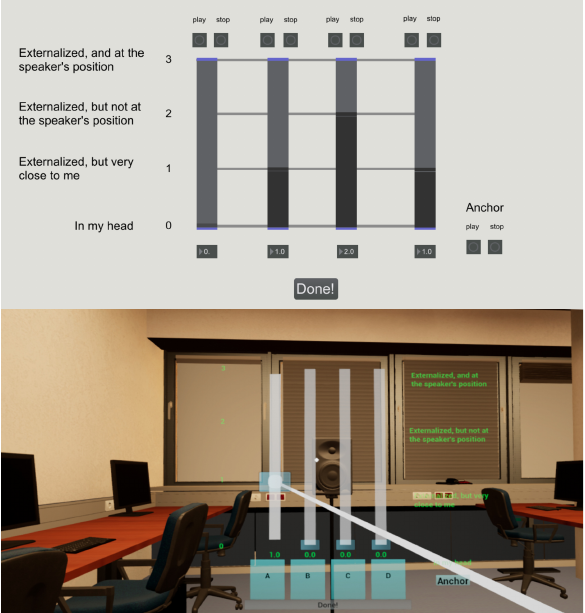
Figure 3. GUI of the externalization experiment ( top : desktop-based listening test (Experiment I); bottom : VR-based listening test (Experiment